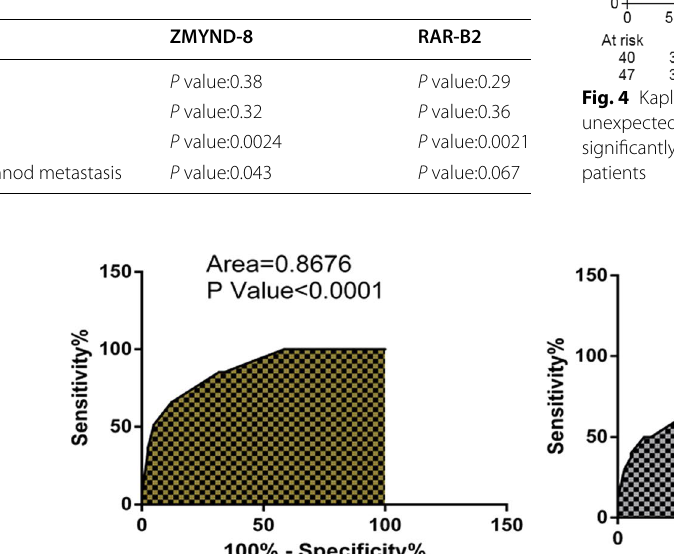
Table 3 Clinicopathological features of patients coloration with